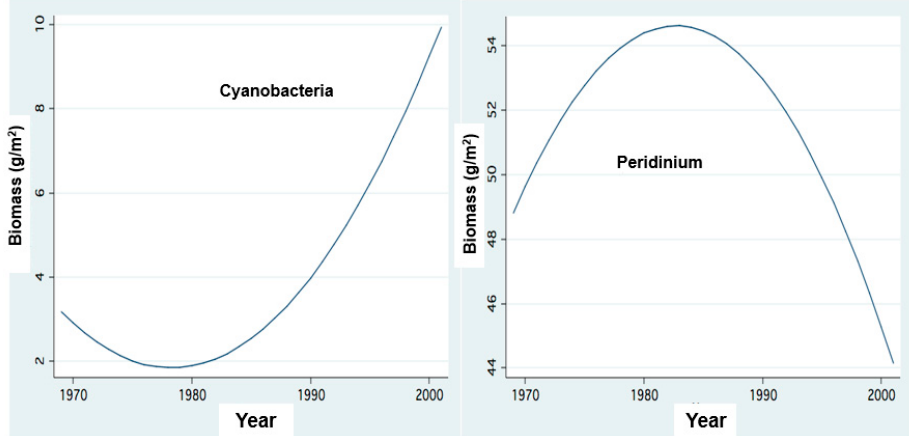
Figure 10. Temporal changes of Cyanobacteria and Peridinium Biomass: FP Regressions between annual averages of Phytoplankton Biomass (g/m 2 ): (Peridinium) and, Cyanophyta and years.